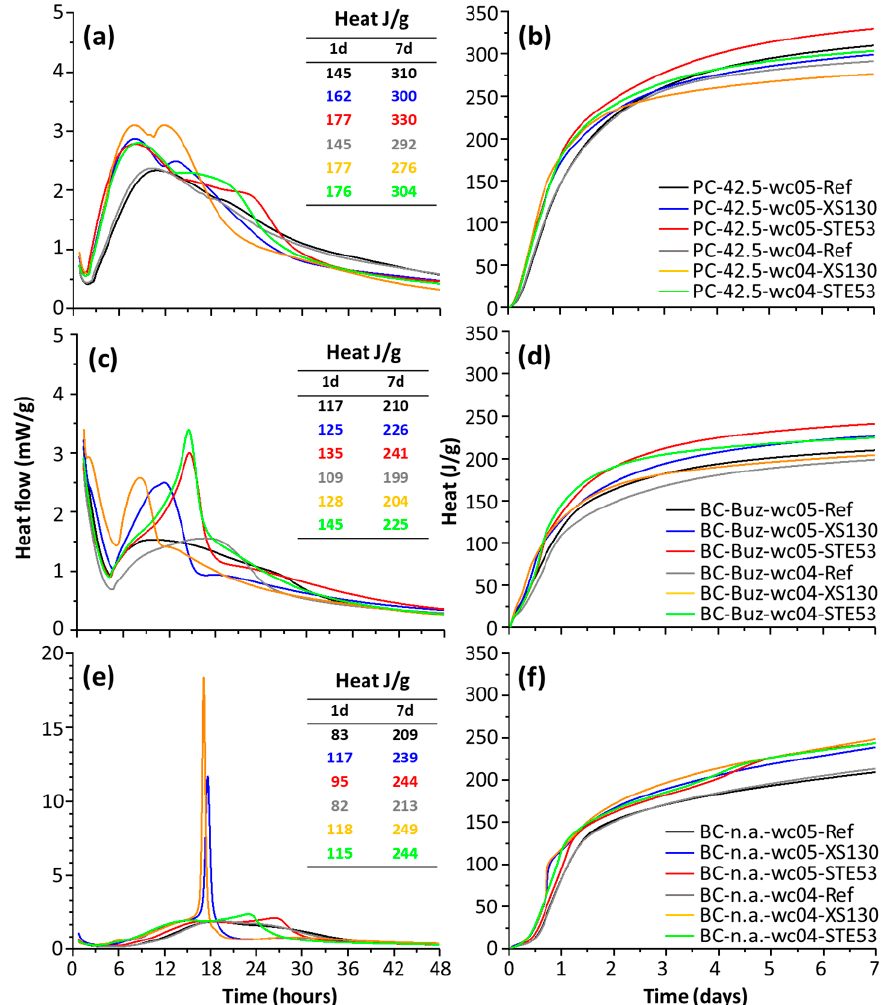
Figure 2. Calorimetries for the eighteen studied pastes, showing the outcomes of the employed accelerator admixtures. The heat flow curves, left panels, are referenced to 100 g of cement and only the first 48 h is shown for clarity. The total heat released, right panels, during the first seven days of hydration. ( a , b ) PC pastes, ( c , d ) BC-Buz pastes, ( e , f ) Non-activated BC pastes. The insets report the heats developed at 1 and 7 days by the studied pastes.